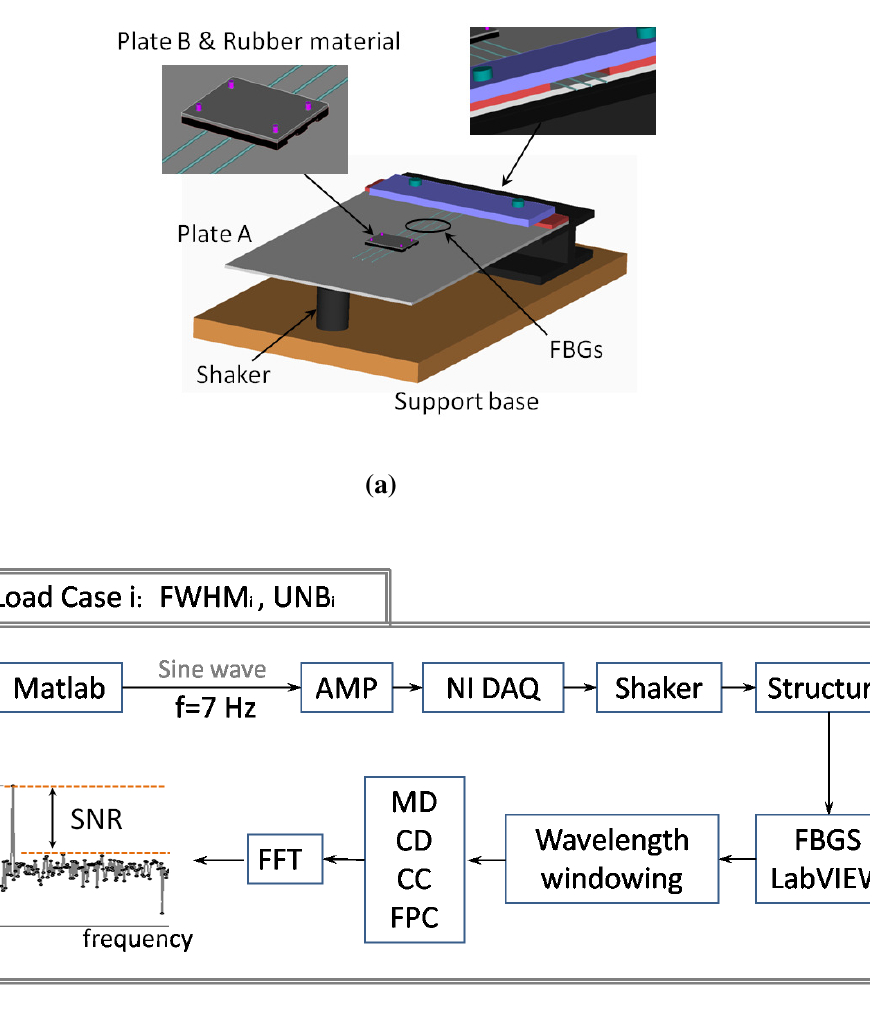
Figure 9. Experimental setup ( a ) and procedure ( b ) used to compare the performance of the different algorithms in terms of the achieved SNR. ( a ) Experimental setup; ( b ) Schematic diagram of the experimental